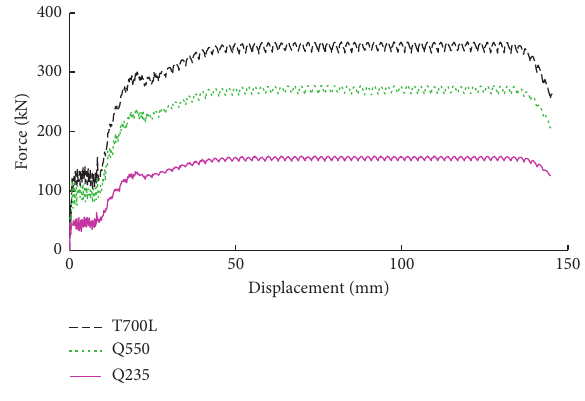
Figure 6: Material force-displacement.